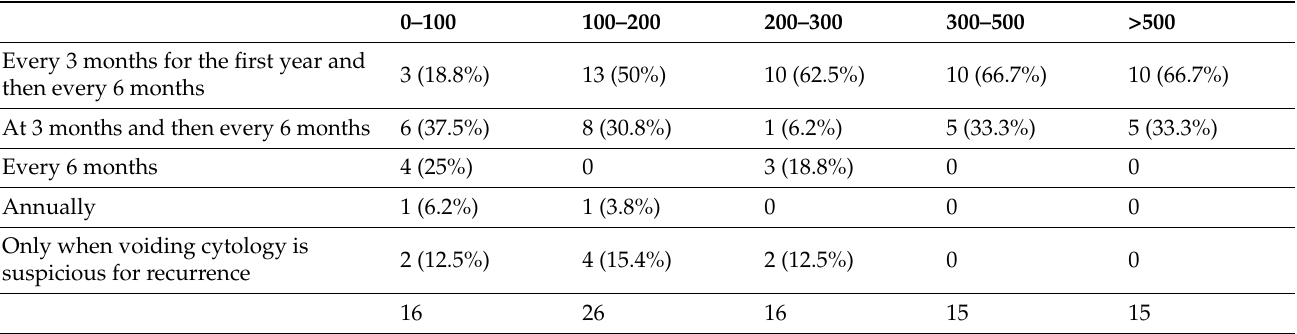
Table 4. Association between annual case volume and endoscopic follow-up